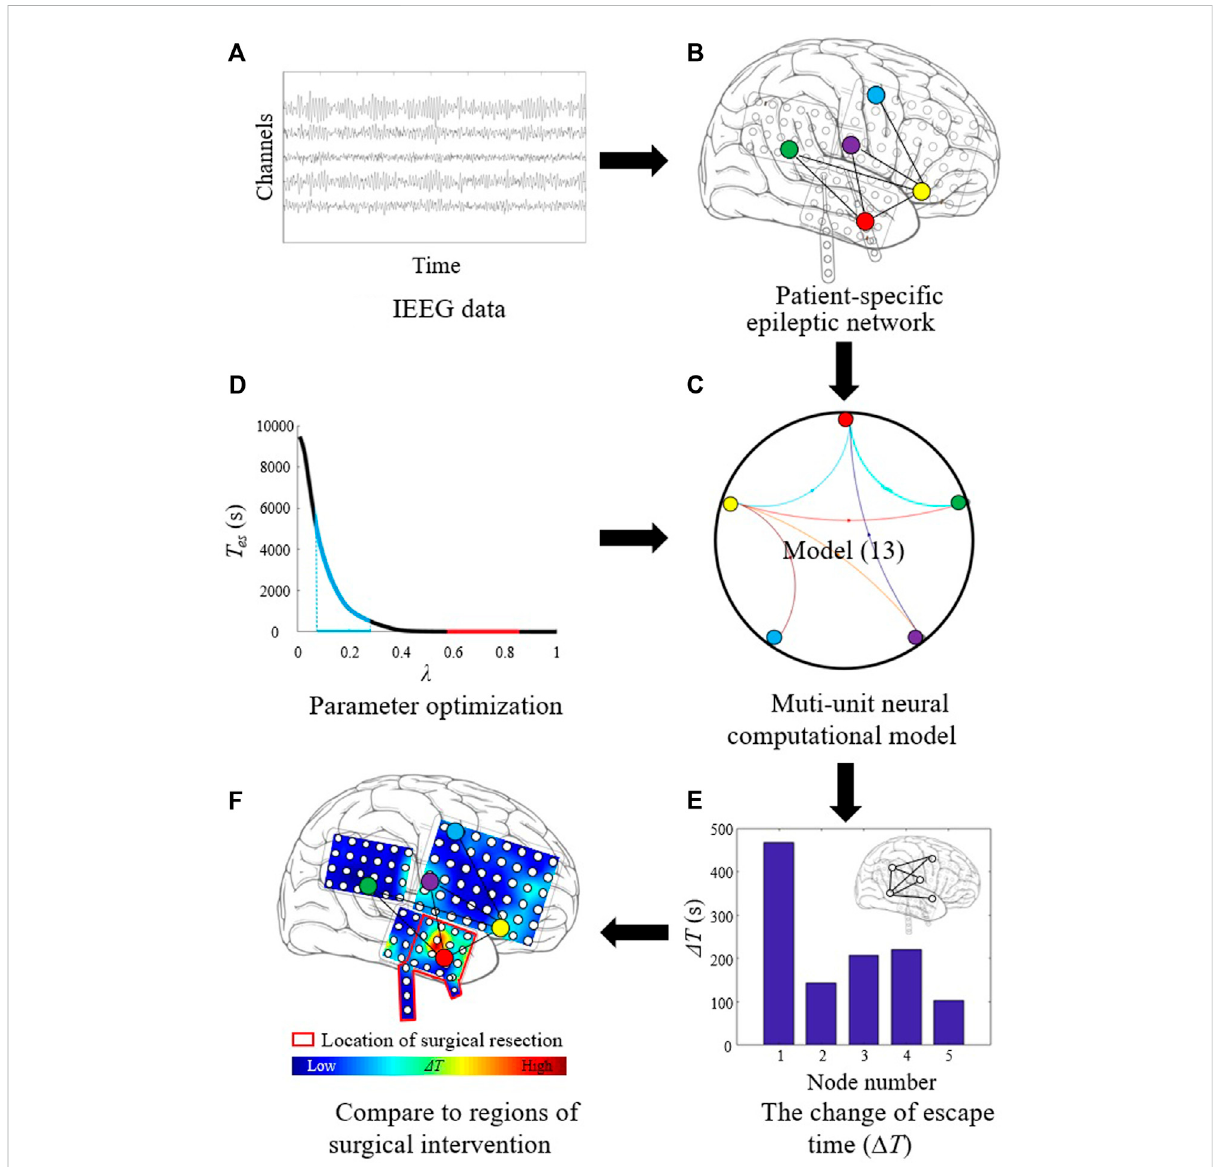
FIGURE 1 Procedureoflocalizingtargetforneuromodulationindrug-resistantepilepsy. (A) ThesegmentediEEGrecordings. (B) Patient-speci fi cepileptic network based on iEEG data. (C) Multi-unit neural computational model based on the epileptic network and the Z6 model. (D) Parameter optimization for λ . (E) Calculating the change of escape time ( Δ T ) of each node. (F) Localizing optimal target with the largest Δ T